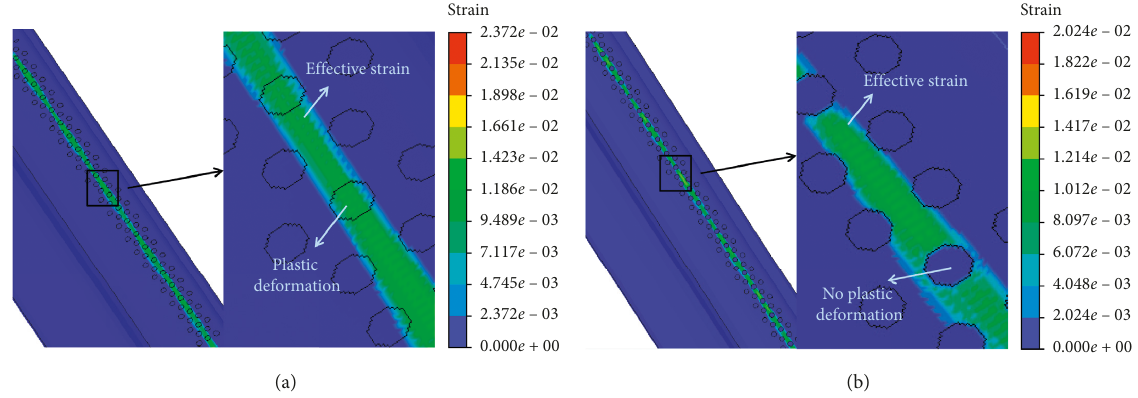
Figure 19: Effective field strain on the rail: (a) nonhardening material; (b) hardening